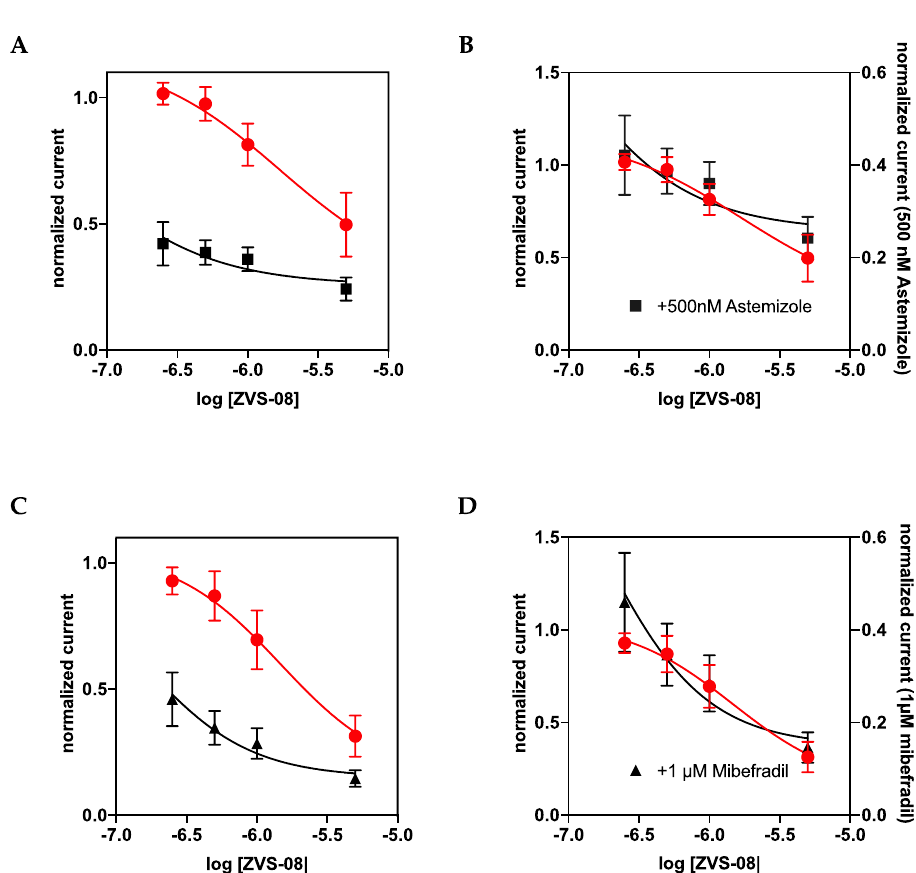
Figure 10. Competition results of ZVS-08 (red circles) with astemizole (known pore blocker, black square) on K V 10.1 ( A,B ) and mibefradil (gating modifier, black triangle) ( C , D ). ( B , D ) represent the same dataset as ( A , C ), but each series is plotted on a different axis to visualise that the dose–response is unchanged in the presence of the competitor. The fits resulted in the same IC 50 for the presence and absence of the competitor (1.69 µM for A and B and 1.47 µM for ( C , D )). Current amplitudes were measured in all cases at the end of a 500 ms depolarising pulse to +40 mV.